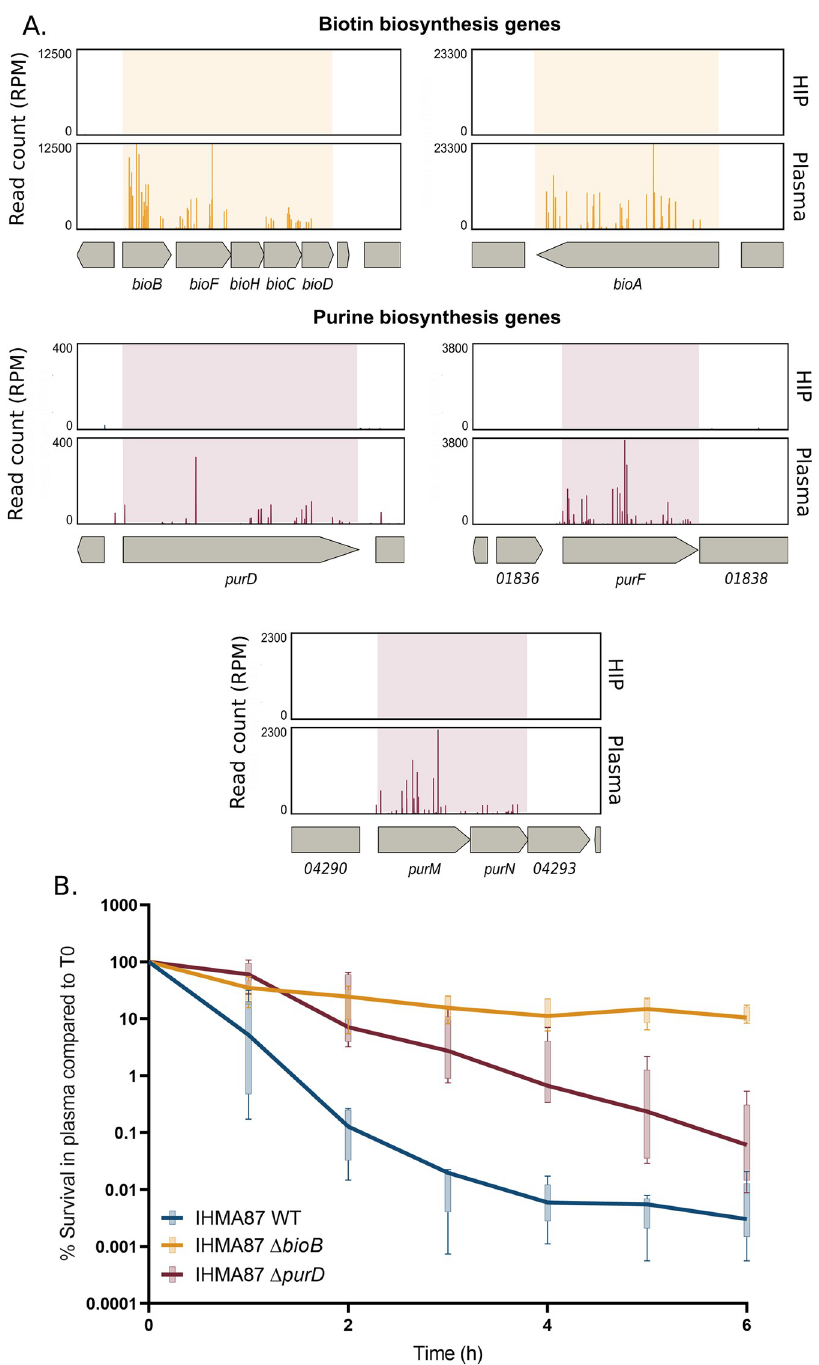
Fig 3. Inactivation of biotin and purine biosynthetic pathways increases survival rates of IHMA87 in plasma. A. Zoom in on Tn-seq profiles of bio and pur genes and operons, showing normalized numbers of reads in input (HIP) and output (plasma) samples. B. IHMA87 wild-type strain, Δ bioB , and Δ purD mutants’ survival kinetics in plasma over 6 h incubation, as measured by CFU counting (n = 5). Note the biphasic killing curves for the parental strain and Δ bioB mutant, indicating increased persistence of Δ bioB . The Δ purD mutant displayed increased tolerance compared to the parental strain.